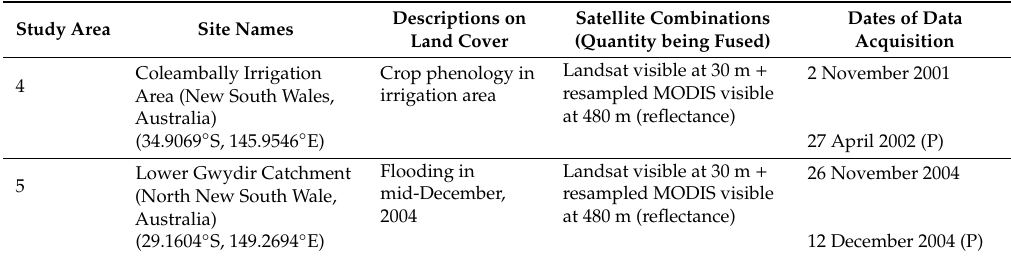
Figure 6. Real datasets: ( a ): Landsat on 11/2/2001 (30 m) for study area 4; ( b ): MODIS on 4/27/2002 (480 m) for study area 4; ( c ): Landsat on 4/27/2002 (30 m) for study area 4; ( d ): Landsat on 11/26/2004 (30 m) for study area 5; ( e ): MODIS on 12/12/2004 (480 m) for study area 5; ( f ): Landsat on 12/12/2004 (30 m) for study area 5. Table 2. Details of study areas for real